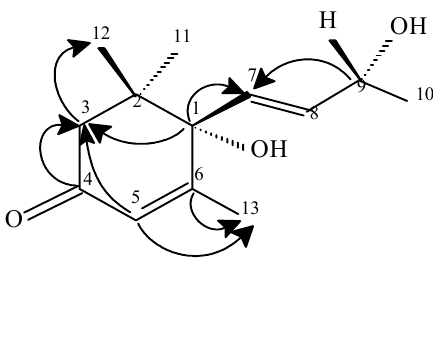
Figure 3. Heteronuclear multiple-bond correlations for 3 . Arrows point from carbon to